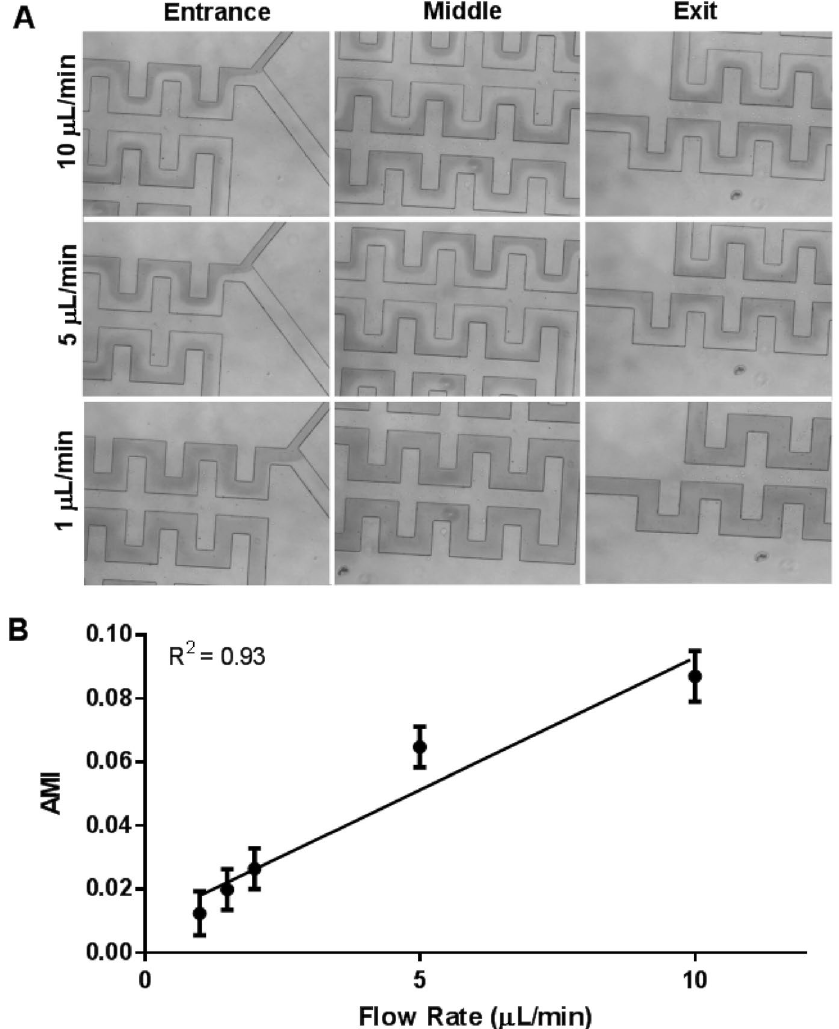
Figure 3. Mixing efficiency. ( A ) Representative microscopy images showing progression of the mixing of PBS and Brilliant Blue FCF in PBS at the entrance, middle, and exit regions of interest within the mixing channels at 10, 5, 2, 1.5, and 1 µL/min. ( B ) The slope of the intensity profile to indicate mixing efficiency at the exit region of the mixing channel as a function of perfusion volumetric flow rate. Calculated absolute mixing index (AMI) at the exit region of the mixing channel as a function of perfusion volumetric flow rate. An AMI value of zero indicates complete